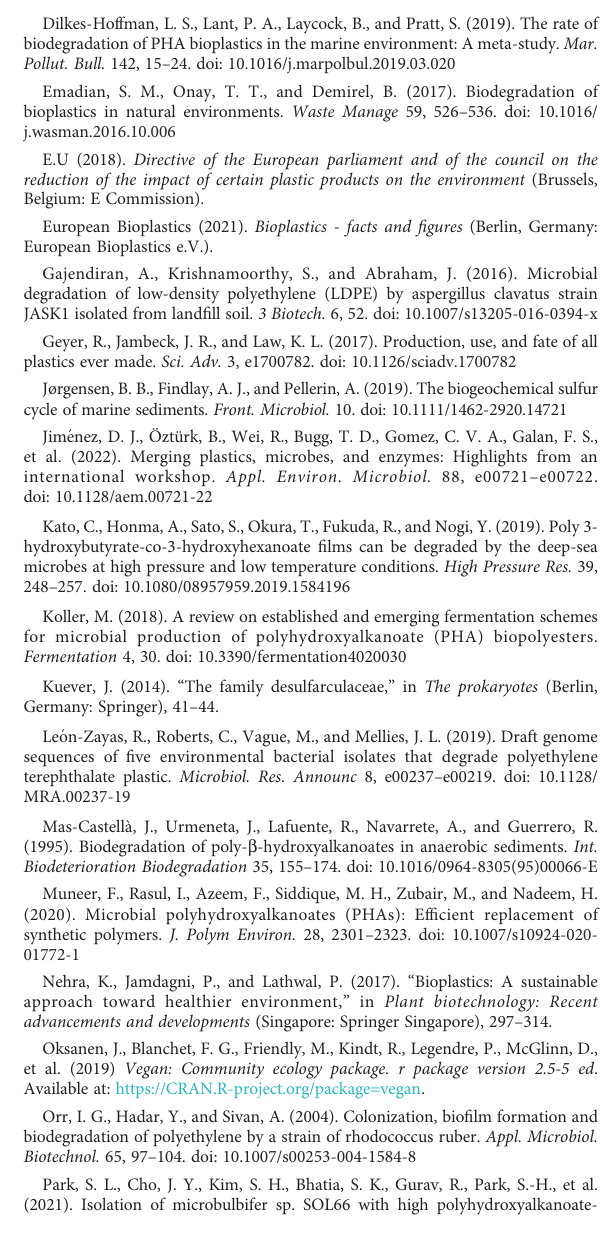
SUPPLEMENTARY FIGURE 1 Scanning electron images of PHA and PET pellets with their associated bio fi lmsatapproximately 25Xmagni fi cation. (A – C) show PHApelletsafter 0, 202, and 424 days of exposure, respectively. (D – F) show PET pellets after 0, 202, and 424 days of exposure,